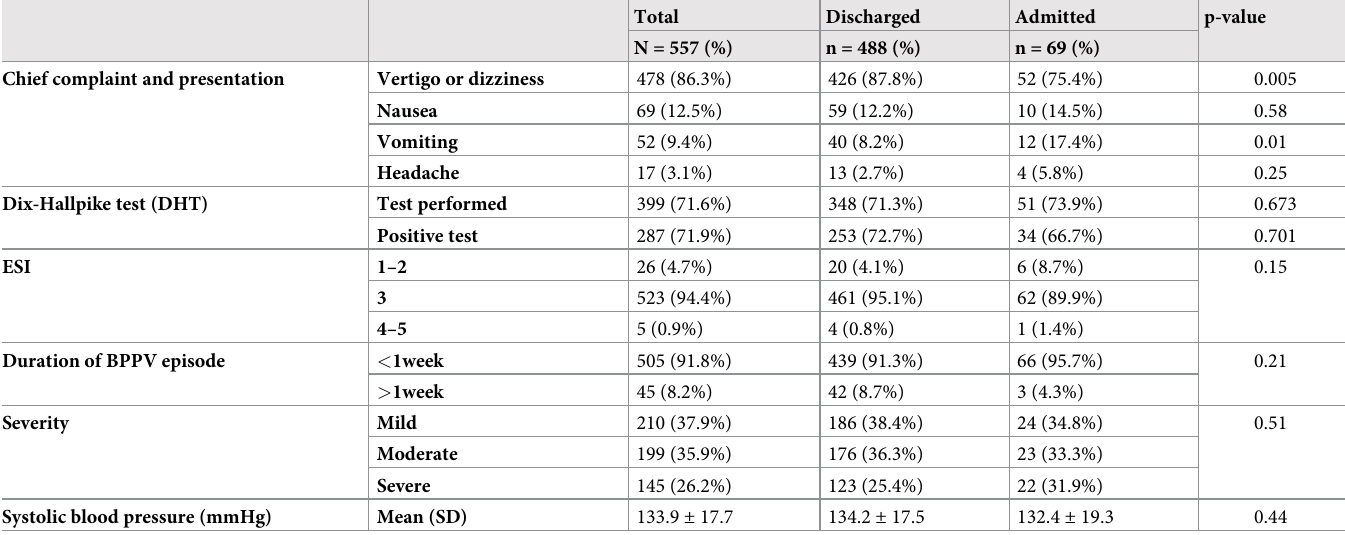
Table 2. Clinical characteristics of BPPV